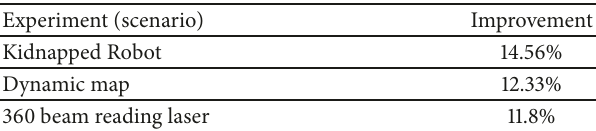
Figure 12: Average error for PF only (blue), hybrid filter only (grey), and hybrid filter coupled with Hector SLAM (orange). Table 1: Decrease or increase of the hybrid PR/FIR filter in relation to PF only